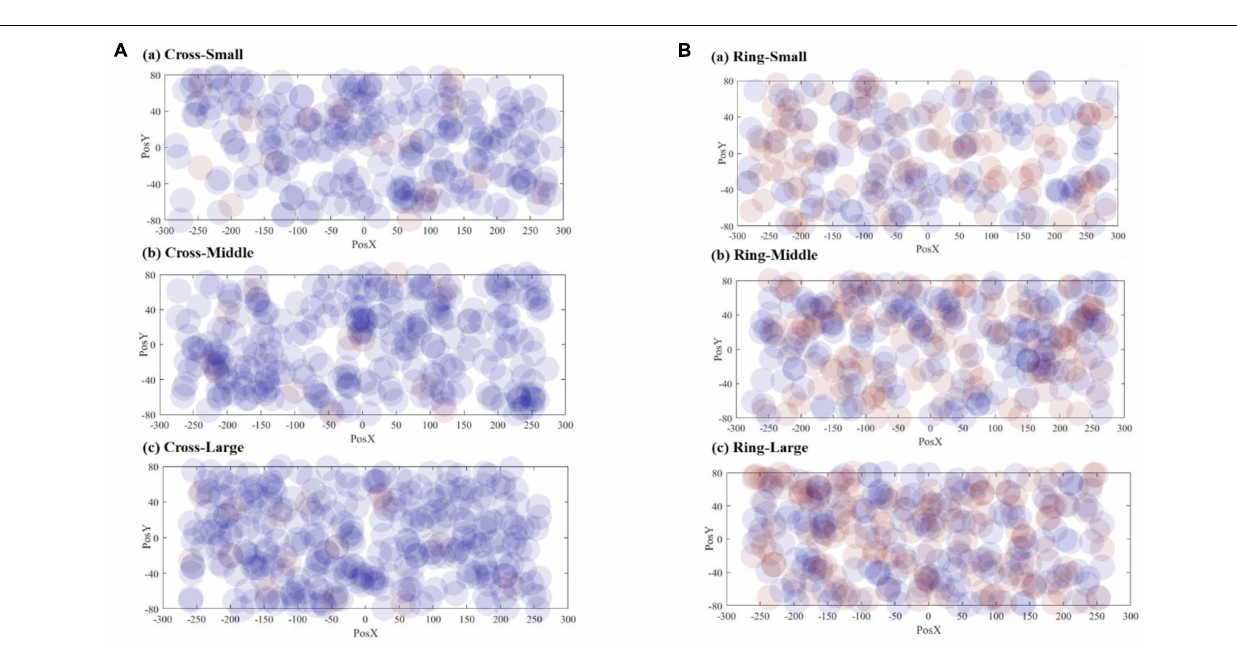
FIGURE 8 | Visualization of correct response numbers: (A) cross VA, (B) ring VA.